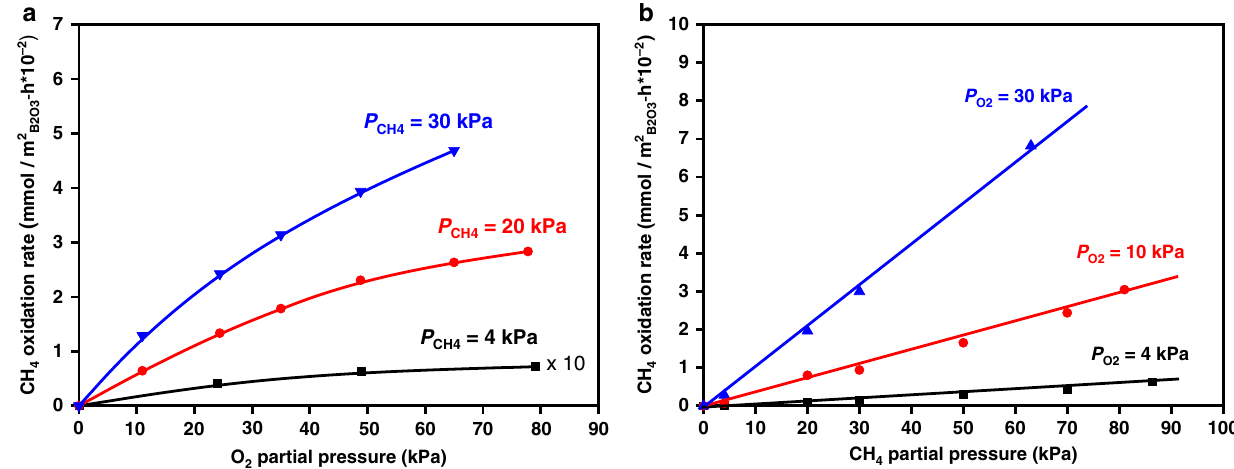
Fig. 2 Kinetics of methane oxidation on supported B 2 O 3 catalysts. Methane oxidation rates as functions of a O 2 pressure and b CH 4 pressure were measured on 20 wt% B 2 O 3 /Al 2 O 3 . Reaction condition: 550°C, 4 – 30 kPa P CH4 , 0 – 80 kPa P O2 for a and 4 – 30 kPa P O2 , 0 – 90 kPa P CH4 for b , balanced by N 2 , space velocity at 4920 mL g cat . − 1 h − 1 . In a , the rate data measured at CH 4 partial pressures of 4, 20, and 30 kPa are shown as black square, red cycle, and blue triangle, respectively. In b , the rates measured at O 2 partial pressures of 4, 10, and 30 kPa were shown in black square, red cycle, and blue triangle, respectively. The curves in a and lines in b represent trends.